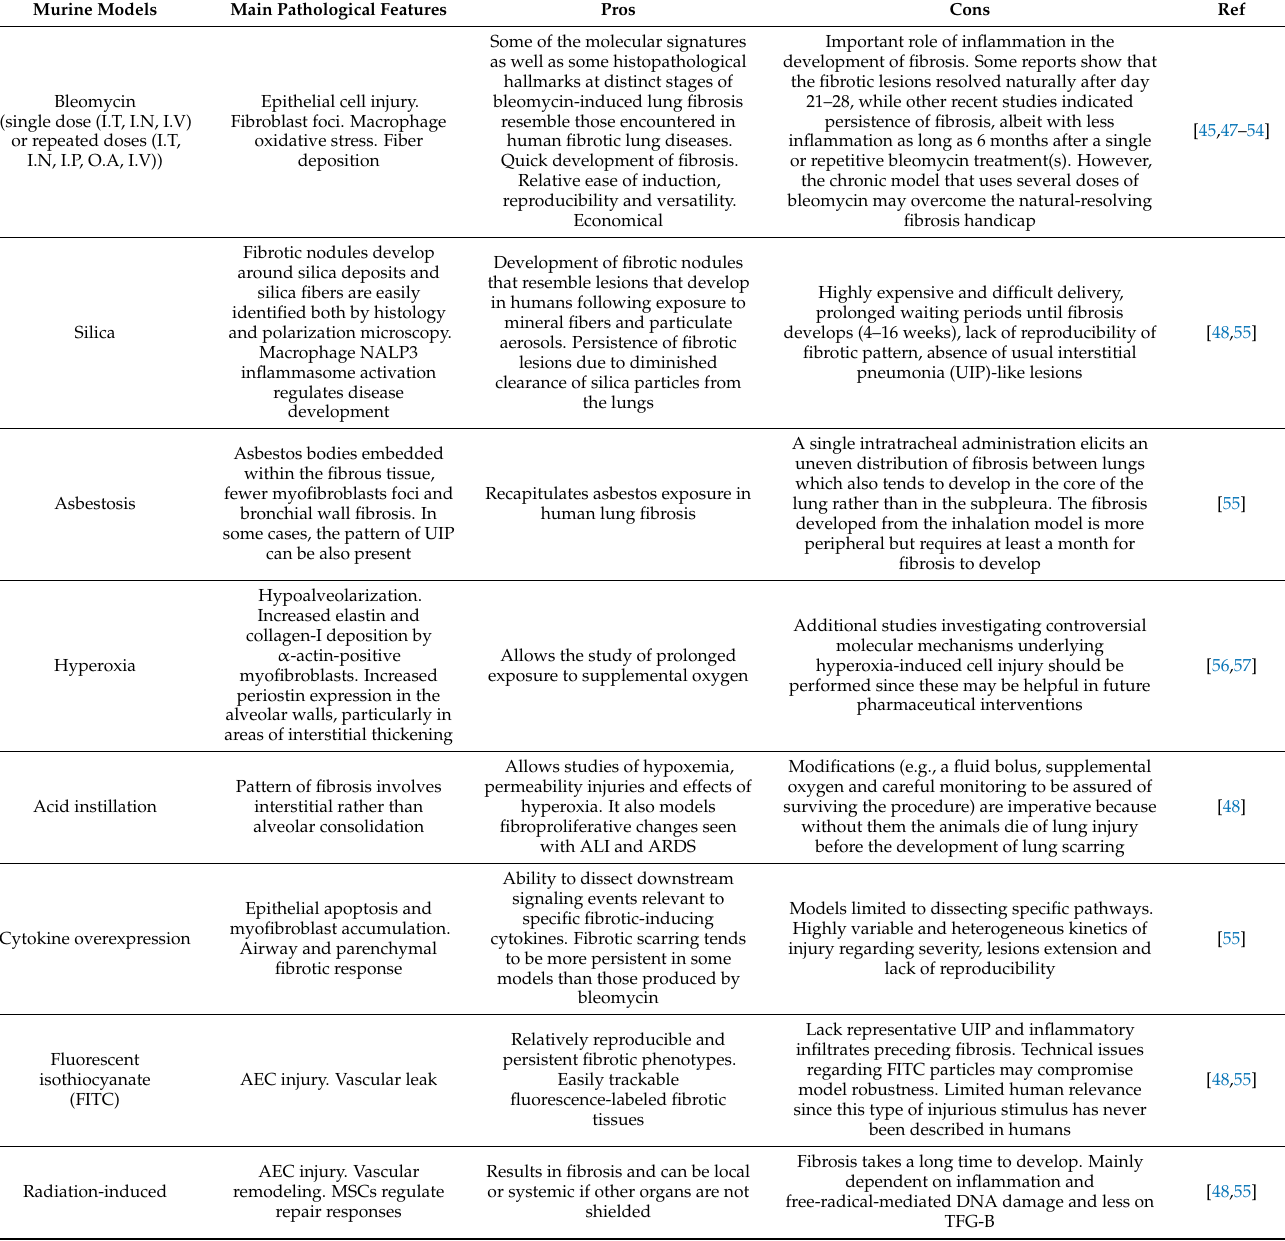
Table 1. Murine models to study lung fibrosis in